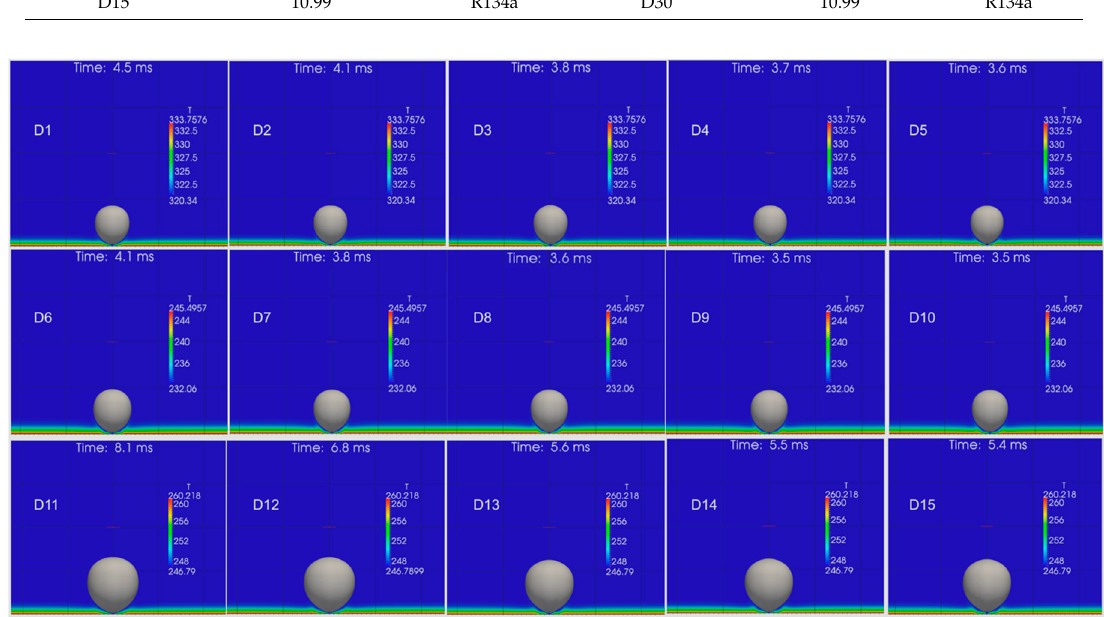
Figure 24. Spatial evolution of generated bubble at the time of detachment for each case of the Series D parametric numerical simulations, with the 1 bar ambient pressure condition.